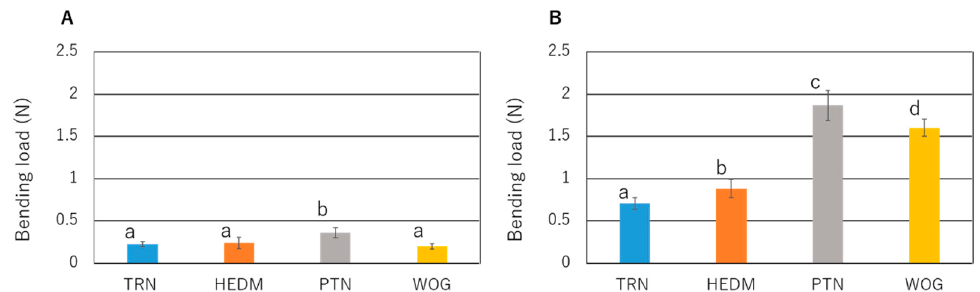
Figure 4. Bending load values (N) of the tested NiTi rotary instruments at a deflection of 0.5 mm (elastic region: A ) and 2.0 mm (superelastic region: B ). Values are means and standard deviations (n = 10). Groups with different letters in each testing condition are significantly different ( p < 0.05; one-way ANOVA and Tukey test).